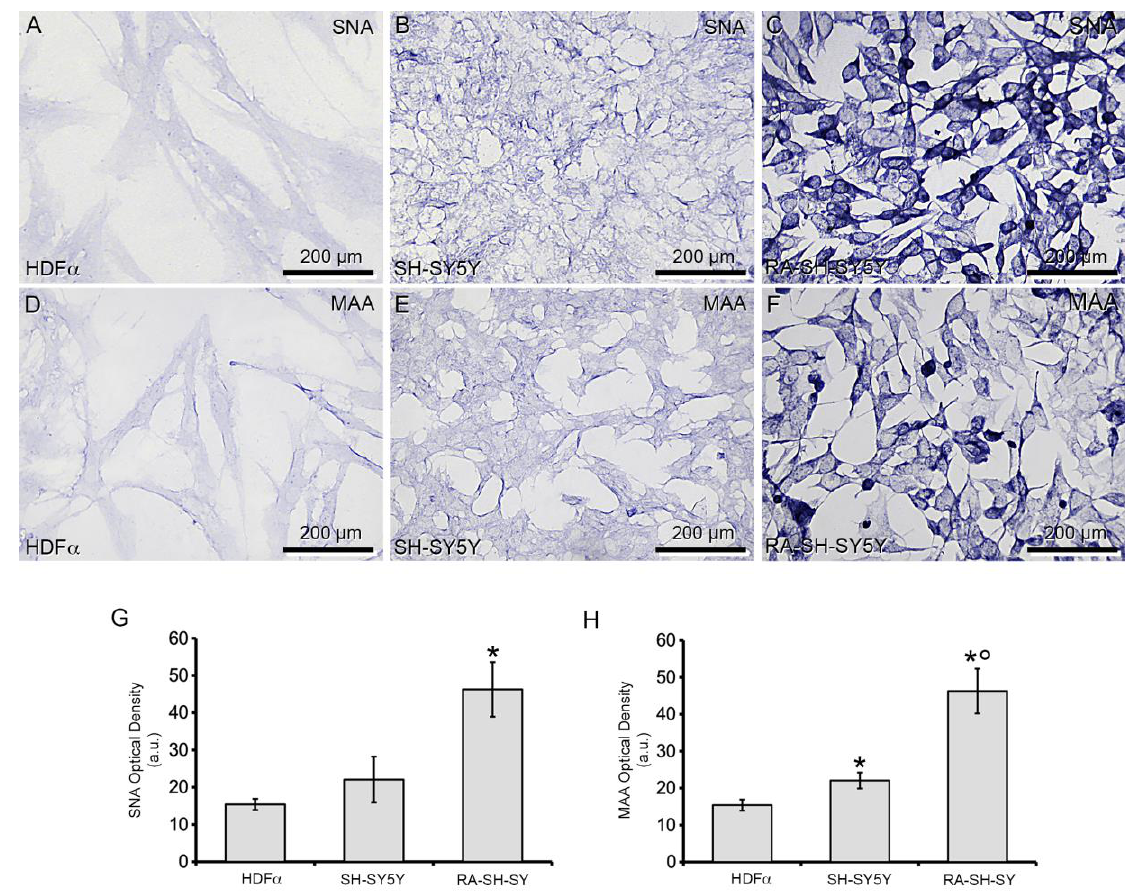
Figure 2. SNA and MAA lectin reactivity. ( A – C ) SNA and ( D – F ) MAA reactivity in HDF α , SH-SY5Y and RA-SH-SY5Y, to reveal Sias α 2,6 linked to Gal/GalNAc and α 2,3 linked to Gal, respectively. ( G , H ) Quantitative analysis of SNA (F (2,6) = 109.01, * p < 0.05 vs. HDF α ) and MAA (F (2,6) = 90.6, * p < 0.05 vs. HDF α , ◦ p < 0.01 vs. SH-SY5Y) reactivity. Data are reported as averages ± SE of three independent